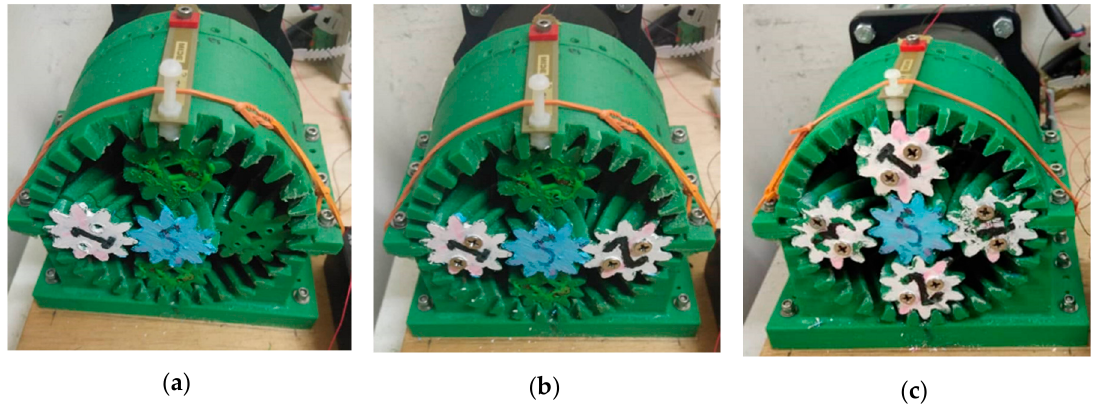
Figure 7. Effect of different planet cover numbers: ( a ) one, ( b ) two and ( c ) three planet covers.